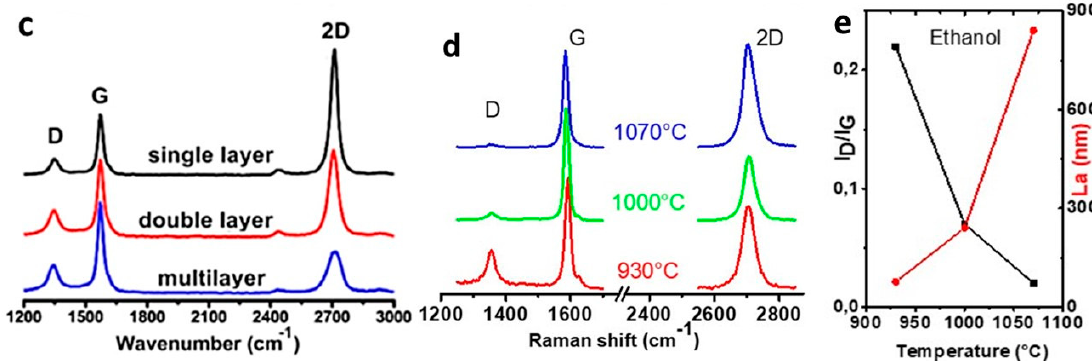
Figure 1. Raman spectra of graphene films grown by CVD of alcohols at di ff erent temperatures. ( a ) Mono-layer graphene grown at 650, 750 and 850 ◦ C, using methanol, ethanol and propanol (I 2D / I G between 2 and 3). Adapted from [40] with permission of Elsevier, Copyright 2011. ( b ) Integrated intensity of D band corresponding to the Raman spectra of ( a ) . Adapted from [40] with permission of Elsevier, Copyright 2011. ( c ) Mono-, bi-, and multi-layer graphene grown at 900 ◦ C, using ethanol (t = 30 min): I 2D / I G = 2.10 and I D / I G = 0.23. Adapted from [39] with permission of Elsevier, Copyright 2011. ( d ) Multi-layer graphene films grown at 930, 1000, and 1070 ◦ C, using ethanol ( Φ H2 = 100 sccm, t = 30 min). Raman spectrum at 1070 ◦ C: I 2D / I G = 1.06 and I D / I G = 0.02. I D / I G and I 2D / I G indicate peak intensity ratios. Original data from our group (unpublished). (e) Corresponding I D / I G and crystallite size, La, as a function of temperature. La was calculated according to the general equation La (nm)